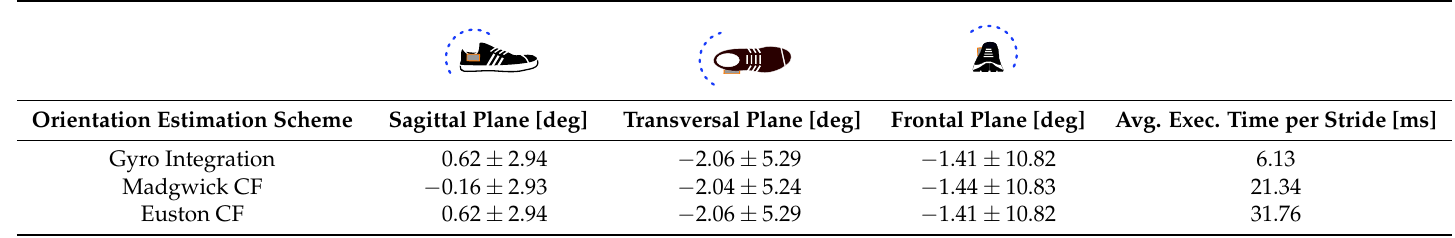
Table 2. Mean ± standard deviation of the error distribution for the estimated angles as well as average execution time for all three orientation estimation schemes with optimal parameter configurations.